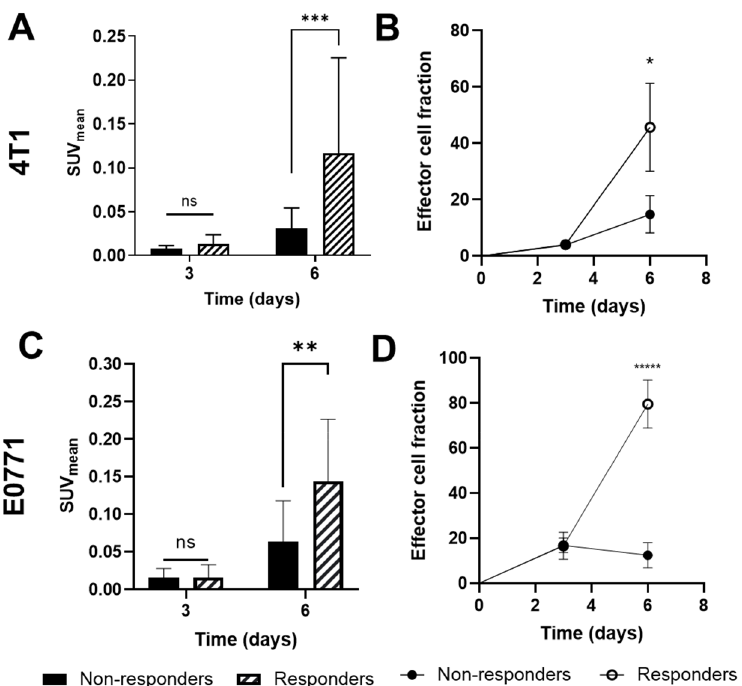
Figure 4. Granzyme B-specific positron emission tomography imaging data of effector cell activation accurately predicts response to immunotherapy (IMT) and chemotherapy in TNBC tumors. SUV mean and effector cell fraction in ( A , B ) 4T1 (non-responders: n = 12; responders: n = 4) and ( C , D ) E0771 tumors (non-responders: n = 11; responders: n = 15). Mean ± SD (“ns” indicates not significant, p > 0.05, * indicates p < 0.05, ** indicates p < 0.01, *** indicates p < 0.001, ***** indicates p < 0.00001; multiple t -tests).